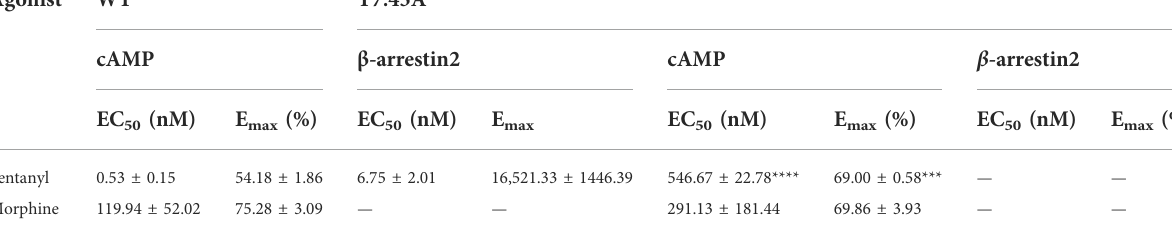
Fentanyl Morphine Half maximal effective concentration (EC 50 ) and maximal effect (E max ) derived from the concentration – effect analysis in the cAMP and ß -arrestin assay. average ± standard error of the mean, n = 3. — : no value. * p < 0.05, ** p < 0.01, *** p < 0.001, **** p < 0.0001 compared with WT group. WT, wild type; cAMP, cyclic adenosine 5 ′